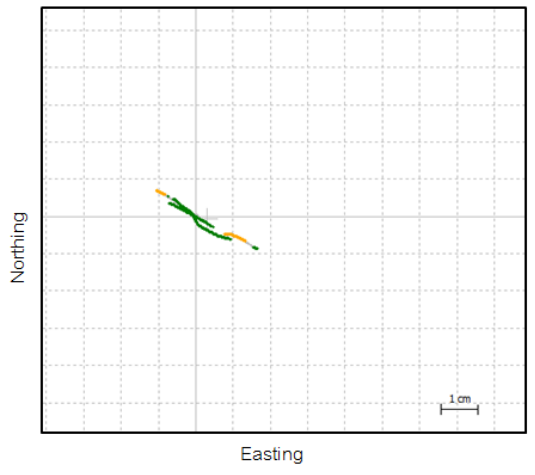
Fig. 14. Plot of the RTK horizontal position components from single frequency GPS module observation on obstructed